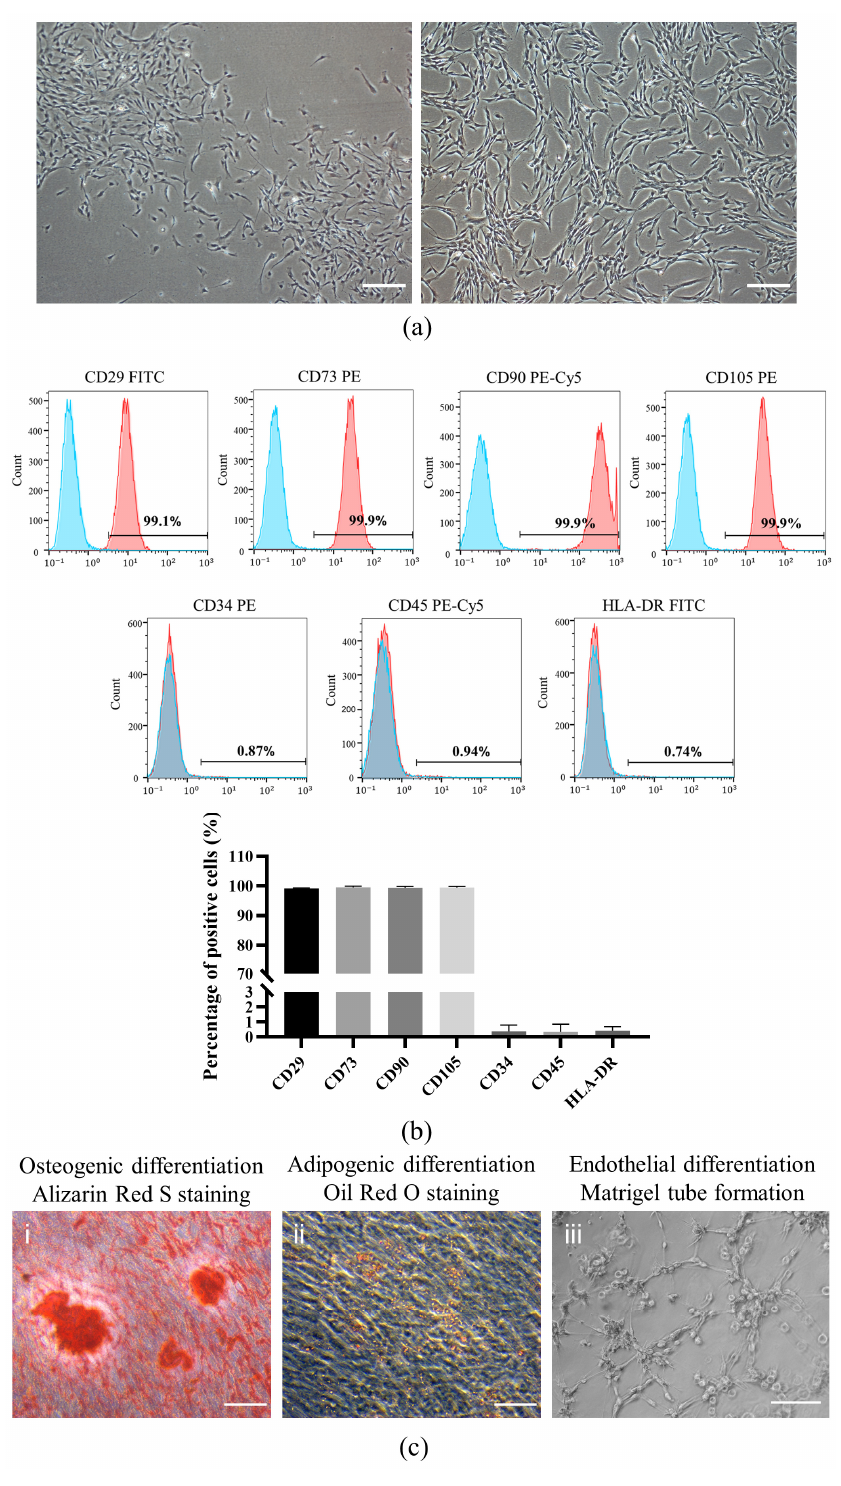
Figure 1. Characterization of DPSCs. ( a ) DPSC morphology was observed under an optical micro- scope. ( b ) DPSC phenotypes were examined by flow cytometry. ( c ) Osteogenic differentiation, adi- pogenic differentiation and endothelial differentiation of DPSCs. n = 3, mean ± SD. Scale bars: 200 μ m ( a , c-iii ); 100 μ m ( c-i , c-ii ). Nor-Exos and Hypo-Exos were isolated from DPSC conditioned media and hypoxia- preconditioned DPSCs, respectively. TEM and NanoFCM were carried out to identify the harvested DPCs-derived exosomes. To characterize the purified particles as exosomes, the bilayer membrane and “saucer-like” appearance of representative exosomes were exam- ined by TEM (Figure 2a). The NanoFCM analysis showed that the diameters of Nor-Exos and Hypo-Exos mainly ranged from 30 to 150 nm (mean size of 70.59 nm for Nor-Exos and 69.42 nm for Hypo-Exos; Figure 2b). Meanwhile, the Western blot analysis revealed that exosomal surface markers CD9, CD63 and CD81 were expressed in Nor-Exos and Hypo-Exos (Figure 2c). These results indicated the successful extraction of Nor-Exos and Hypo-Exos. 3.3. Hypo-Exos Enhance the Angiogenic Capacity of HUVECs In Vitro Nor-Exos and Hypo-Exos (10 μ g/mL) were added to stimulate HUVECs and explore their functional effects on HUVECs. Firstly, to clarify whether Nor-Exos and Hypo-Exos could be taken up by HUVECs, we labeled Nor-Exos and Hypo-Exos with red fluorescent dye PKH26 and incubated them with HUVECs at 37 °C. After 6 h, PKH26-labeled exo- somes were taken up by HUVECs, mainly localized in the cytoplasm around the nucleus (Figure 3a). The HUVEC proliferating effects of exosomes were measured by the CCK-8 assay. Results showed that HUVEC proliferation was significantly increased at three days in the presence of either Nor-Exos or Hypo-Exos. Furthermore, HUVECs in the Hypo- Exos group exhibited higher proliferation compared with the Nor-Exos group (Figure 3b). Additionally, the migration of HUVECs was evaluated with a transwell assay. Compared to the control group, the number of migrating cells significantly increased in the Nor-Exos and Hypo-Exos groups. Moreover, Hypo-Exos exhibited a much stronger effect on HU- VEC migration than Nor-Exos (Figure 3c,d). The above results suggested that Hypo-Exos exhibited stronger effects on HUVECs proliferation and migration than Nor-Exos in vitro. To investigate whether hypoxia could enhance the angiogenic capacity of DPSCs- Exos, Matrigel tube formation assays were performed using HUVECs pretreated with PBS, Nor-Exos, or Hypo-Exos 24 h. Both Nor-Exos and Hypo-Exos promoted greater tube formation of HUVECs at 6 h when compared to the control group (Figure 4a). Meanwhile, the stimulation of Hypo-Exos resulted in more junctions and longer tubes than Nor-Exos stimulation. To explore the potential mechanism through which Hypo-Exos promote an- giogenesis, we detected the expression of several angiogenesis regulatory molecules in HUVECs, including VEGFA/KDR, SDF-1/CXCR4, CD31 and MMP9. The stimulation of Nor-Exos or Hypo-Exos for 24 h upregulated expression of most angiogenesis associated factors in HUVECs (Figure 4b–d). Interestingly, Hypo-Exos significantly upregulated